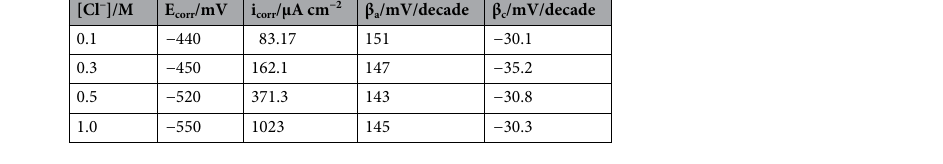
Table 2. Electrochemical corrosion parameters of Mo electrode as a function of NaCl concentration in 3.0 M phosphoric acid at 298 K.